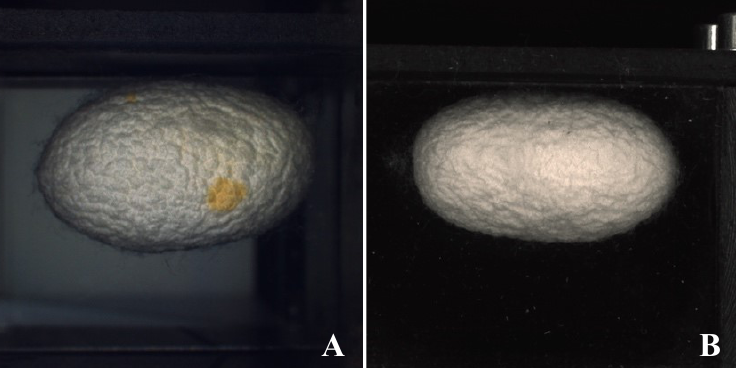
Figure 4. Images taken from the top camera ( A ) and bottom camera ( B ). The first picture shows evident staining (orange spot) that is not observable in the second camera acquisition.